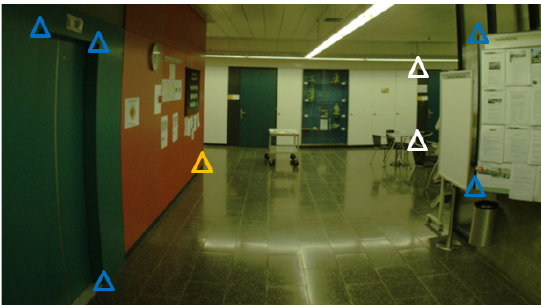
Figure 9. Image section from camera head cam0 with marked Figure 11. Georeferenced mobile mapping images (red) and 3D ground control points (white) as well as check points tie points (black) at our indoor test site using our modified (blue and orange) COLMAP processing